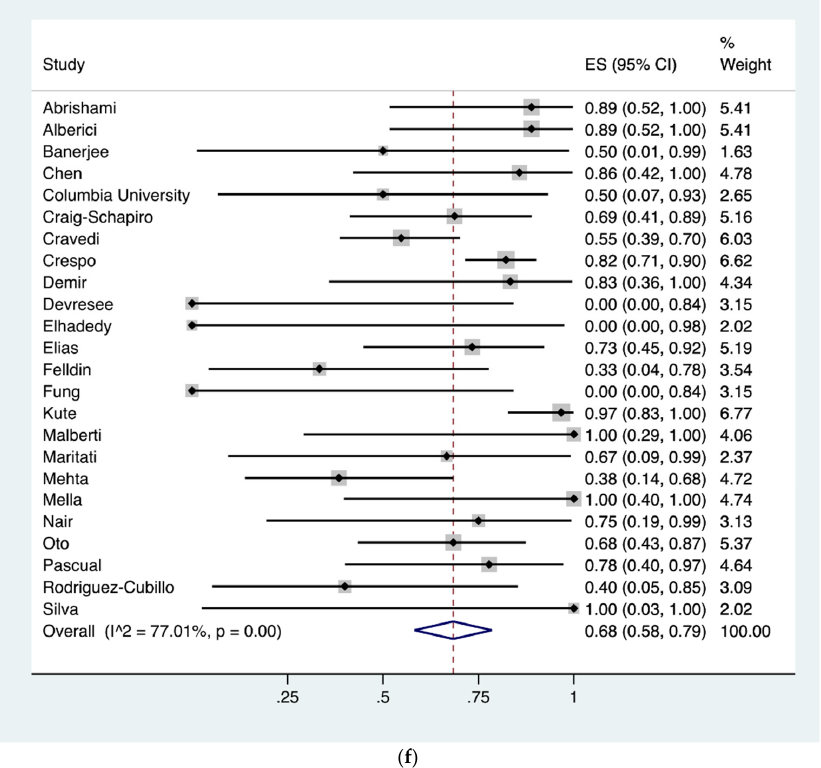
Figure 3. ( a ) Pooled prevalence of in-hospital mortality in kidney transplant recipients diagnosed with corona virus disease 2019 (COVID-19). In-hospital mortality was outlined in 718/3137 patients (48 studies). The vertical red dashed line represents the overall mean effect size of the studies (0.22) and prevalence of 22%. The edges of the blue diamond represent 95% confidence intervals (0.19–0.24); ( b ) Pooled prevalence of intensive care unit (ICU) mortality in kidney transplant recipients diagnosed with COVID-19. ICU mortality was outlined in 184/355 patients (24 studies). The vertical red dashed line represents the overall mean effect size of the studies (0.53) and prevalence of 53%. The edges of the blue diamond represent 95% confidence intervals (0.44–0.63); ( c ) Pooled prevalence of intensive care unit (ICU) admission in kidney transplant recipients diagnosed with COVID-19. ICU admission data were required in 570/2439 patients (37 studies). The vertical red dashed line represents the overall mean effect size of the studies (0.26) and a prevalence of 26%. The edges of the blue diamond represent 95% confidence intervals (0.22–0.30); ( d ) Pooled prevalence of acute respiratory distress syndrome (ARDS) in kidney transplant recipients diagnosed with COVID-19. ARDS was present in 197/344 patients as reported in 13 studies. The vertical red dashed line represents the overall mean effect size of the studies (0.58) and a prevalence of 58%. The edges of the blue diamond represent 95% confidence intervals (0.48–0.69); ( e ) Pooled prevalence of mechanical ventilation requirement in kidney transplant recipients diagnosed with COVID-19. Mechanical ventilation was needed in 433/1848 patients (33 studies). The vertical red dashed line represents the overall mean effect size of the studies (0.24) and prevalence of 25%. The edges of the blue diamond represent 95% confidence intervals (0.20–0.28); ( f ) Pooled prevalence of mortality while on invasive ventilation in kidney transplant recipients diagnosed with COVID-19. Mortality in patients requiring invasive ventilation was 206/285 as reported (24 studies). The vertical red dashed line represents the overall mean effect size of the studies (0.68) and prevalence of 68%. The edges of the blue diamond represent 95% confidence intervals (0.58–0.79).